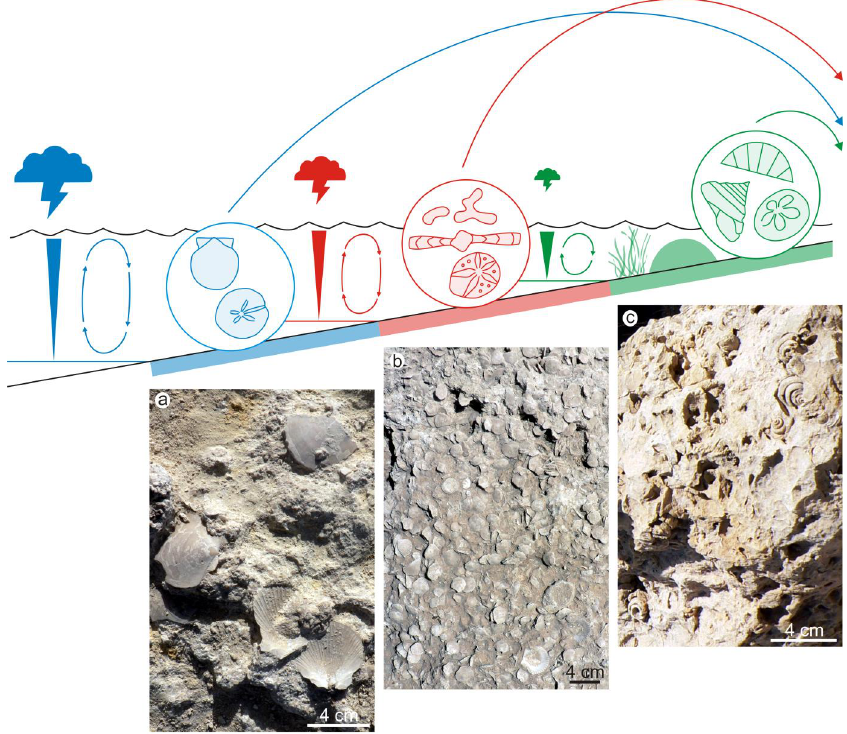
Fig. 5. Facies model for shallow-marine tempestite deposition on the Kachchh Mainland Uplift carbonate ramp illustrating the relationships of skeletal composition and storm intensity (cloud symbol: green=weak, red=moderate, blue=strong). The thick vertical arrowheads indicate the storm wave base depth; the symbols representing the defined tempestite biotic assemblages refer to Fig. 2. (a) Tempestites with abundant Amussiopecten represent the deepest storm wave base. (b) A moderately deep storm wave base is indicated by reworking and nearshore deposition of large lepidocyclinids. (c) Gastropod shell beds document storm reworking in shallow